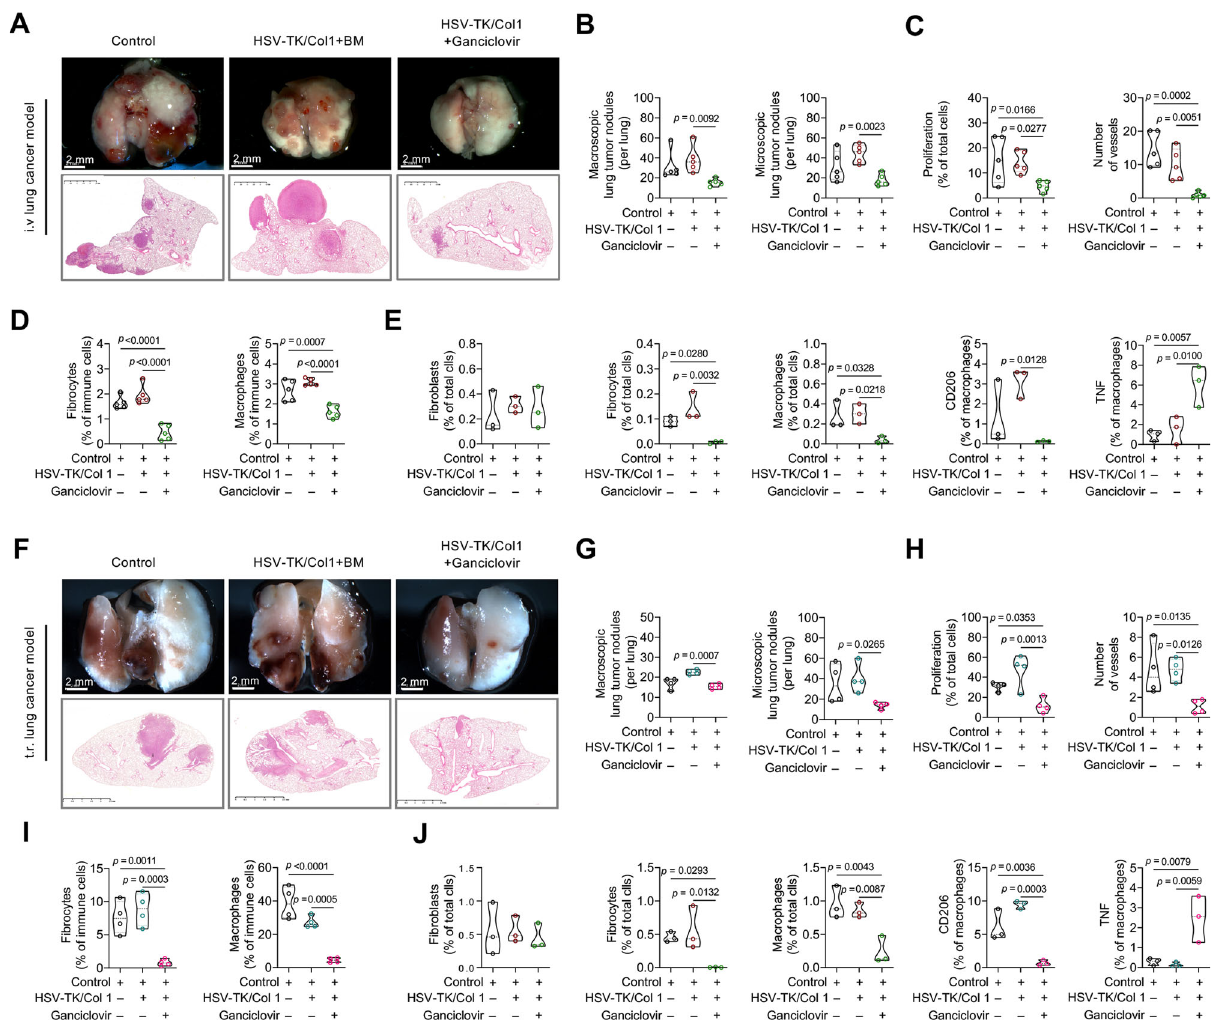
Fig. 3 | Fibrocyte depletion reduces lung tumor progression in LLC1 syngeneic mouse lung tumor models. A Photographs (upper panel) of whole lung (scale bar, 2mm) and Hematoxylin and eosin (H&E) stainings (down panel) of lung sections (scale bar, 2.5mm) that represents intravenous (i.v.) lung metastasis model in fi brocyte-depleted (HSV-TK/Col1+Ganciclovir) and control mice (HSV- TK/Col1+BM and control), n =5. B Quanti fi cation of macroscopic and micro- scopic lung tumor nodules from fi brocyte-depleted and control lung tumors, n =5. C Quanti fi cation of PCNA + proliferating cells ( n =5, 7 images per lung tumor) and vWF + vessels ( n =5, 5 images per lung tumor) from fi brocyte- depleted and control lung tumors by immunohistochemistry. D Quanti fi cation of fi brocytes (CD45 + CD162 + F4/80 + CD9 + CCR2/5 + ) and macrophages (CD45 + CD162 + F4/80 + CD9 – CCR2/5 – ) from fi brocyte-depleted and control lung tumors by FACS analysis, n =5. E Quanti fi cation of fi broblasts (CD45 – CD163 – Col1 + ), fi brocytes (CD45 + CD163 + CCR2 + Col1 + ), and macrophages (CD45 + CD163 + CCR2 – Col1 – ), M2-like (CD206 + ) and M1-like (TNF + ) macrophages from fi brocyte-depleted and control lung tumors by multiplex immuno- fl uorescence, n =3. F Representative photographs (upper panel) of whole lung